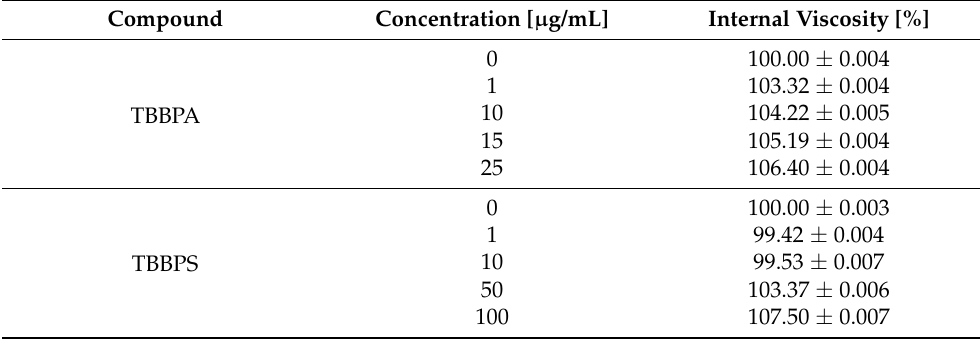
Table 2. Internal viscosity of human control erythrocytes and the erythrocytes incubated with TBBPA at 1 to 25 µ g/mL incubated and TBBPS at 1 to 100 µ g/mL for 48 h. (*) Significantly different from control ( p <